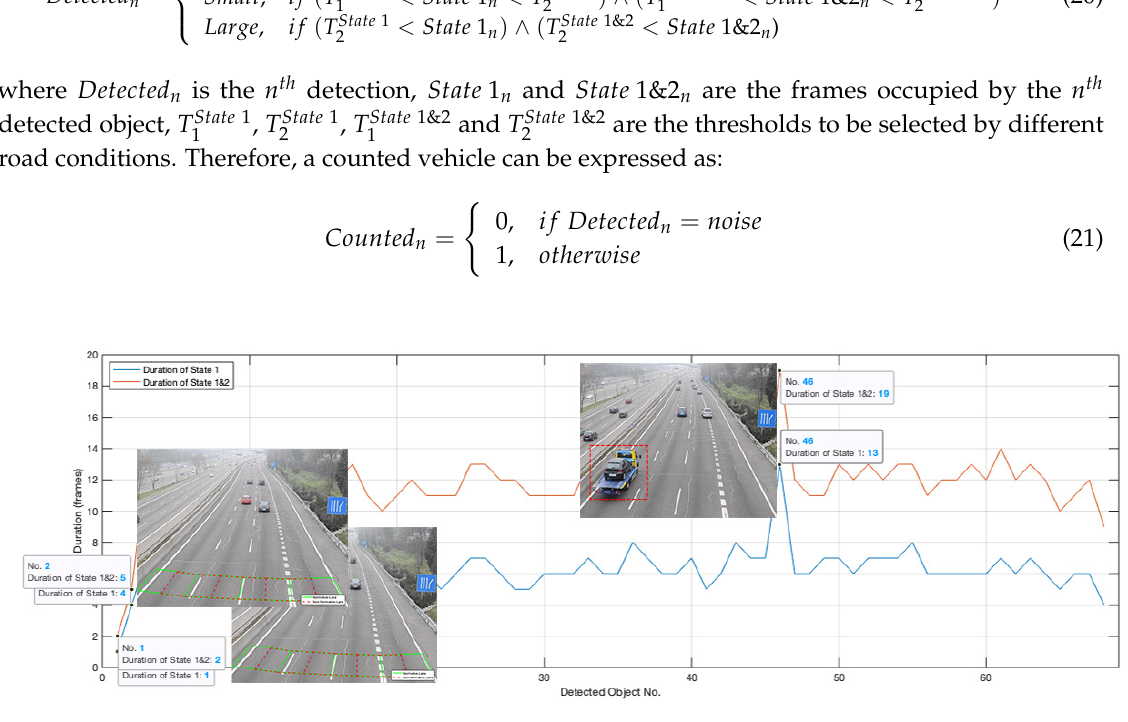
Figure 10. The interpretation for the meaning of State 1 and State